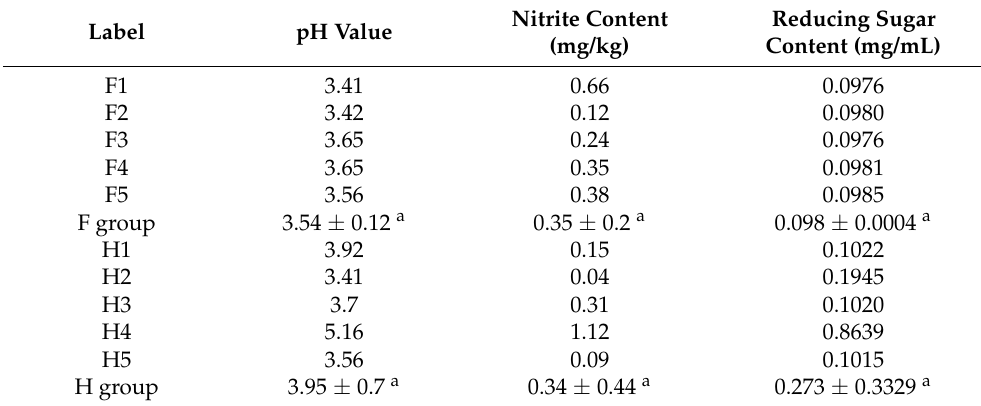
Table 1. pH value, nitrite content and reducing sugar